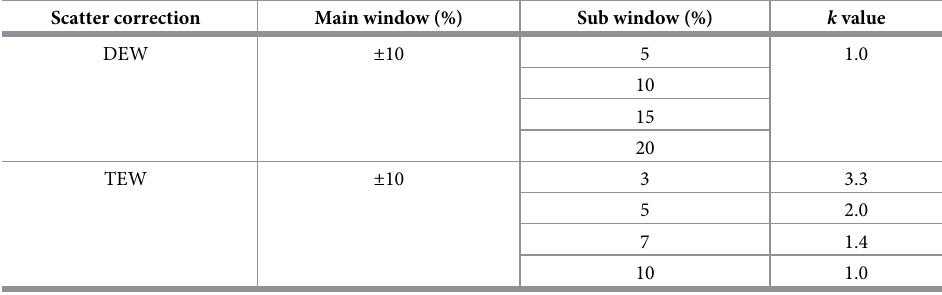
Table 1. Overview of energy window widths and scatter correction factors for energy window scatter